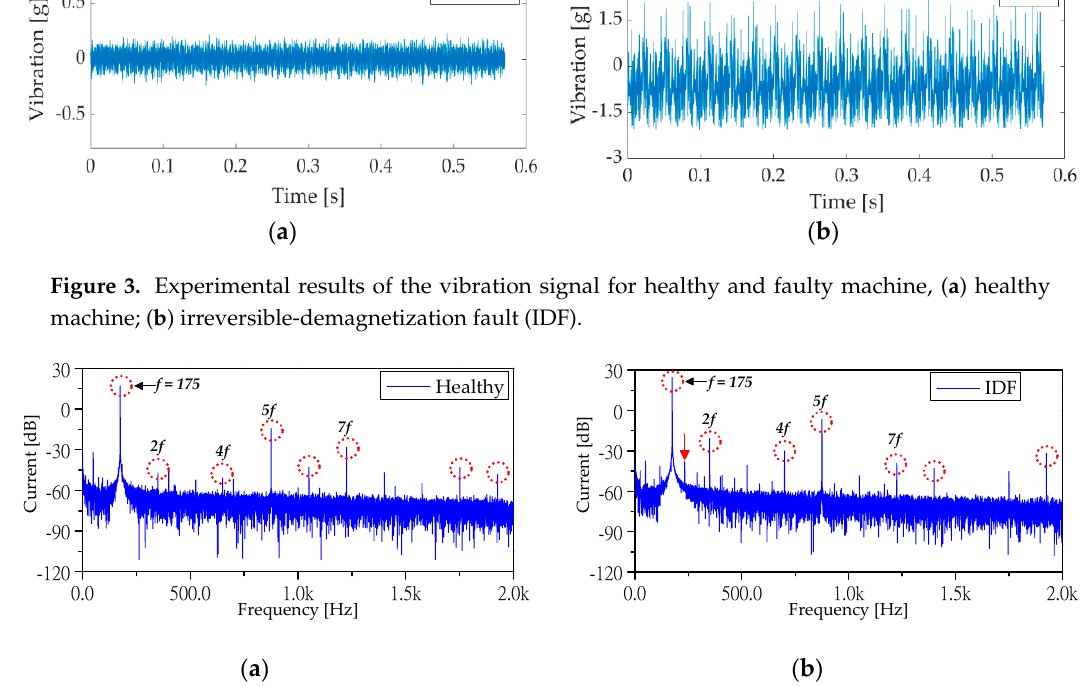
( b ) Figure 6. Mechanism of the damaging bearing using electrical stress: ( a ) schematic diagram of the mechanism; ( b ) experimental setup. ( a ) ( b ) Figure 7. Microscopic view of the bearing: ( a ) healthy bearing; ( b ) damaged bearing.